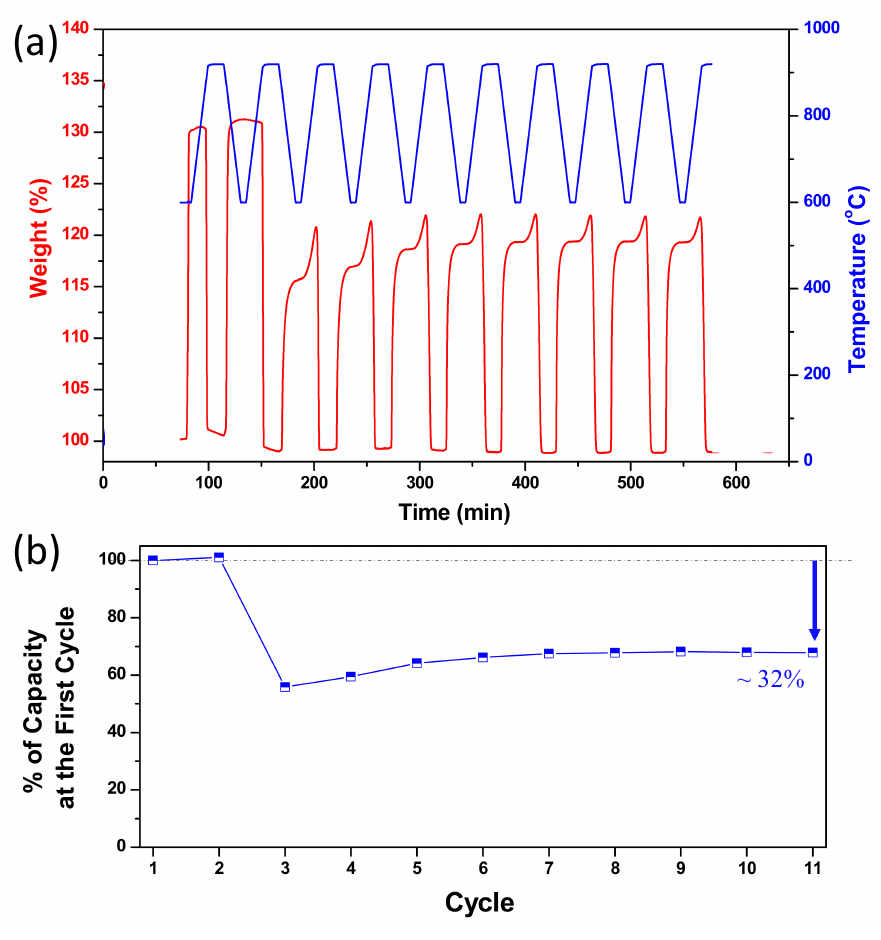
Figure 8. Ten cyclic repeating experiment results of CaTi-3 ( a ), and the percentage of capture capacity of each cycle to the first cycle ( b ).